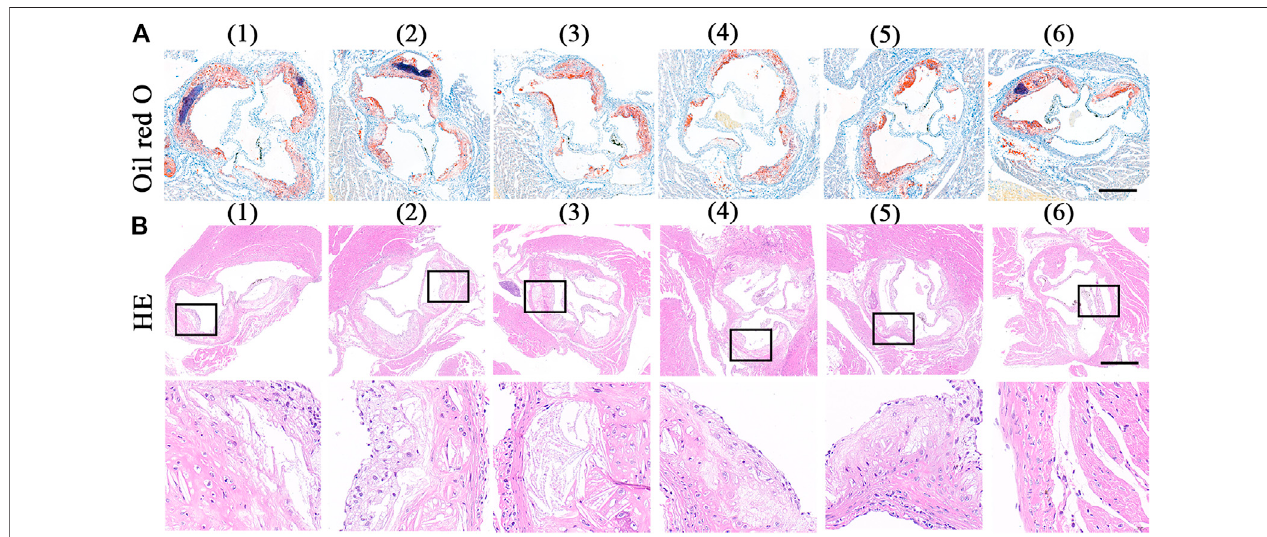
FIGURE6| OROandHEstainingofsectionsofaorticroots. (A) theORO-stainedimagesofaorticrootssections(Wangetal.,2021).-(CostaglioladiPolidoroetal., 2021)referredto(Wangetal.,2021)PBS(Libby,2012);freeRAP(ShapiroandFazio,2016);RAP@NPs(Moriya,2019);RAP@PLTNPs(Winkeletal.,2014);RAP@NPs+ SonoVue ™ + US (Costagliola di Polidoro et al., 2021); RAP@PLT NPs + SonoVue ™ + US; scale bar = 500 µm. (B) the HE staining sections of aortic roots sections and the enlarged version of the plaque area; scale bar = 500 µm.